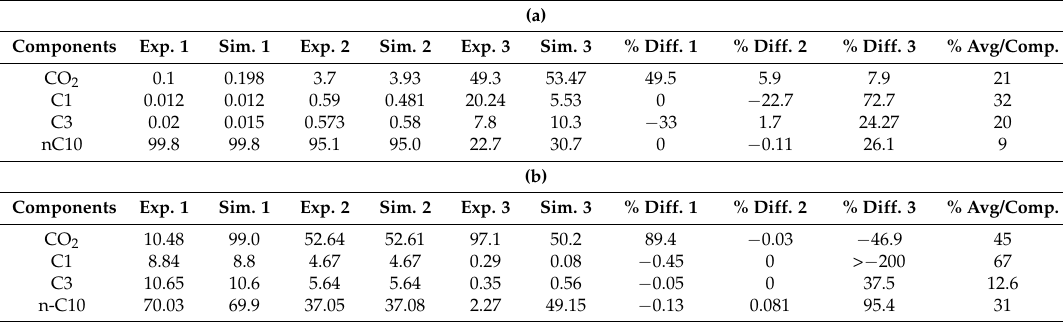
Table 4. ( a ) Comparison between the experimental and the simulation results for the flooded model oil (n-C10) with CO 2 /C1/C3. The total average difference is about 21%. Note that the negative values indicate exp. data > sim. data. ( b ) Comparison between the experimental and the simulation results for the flooded live model oil B (n-C10/C1/C3) with CO 2 /C1/C3. The total average difference is about 39%. Note that the negative values indicate exp. data > sim. data.